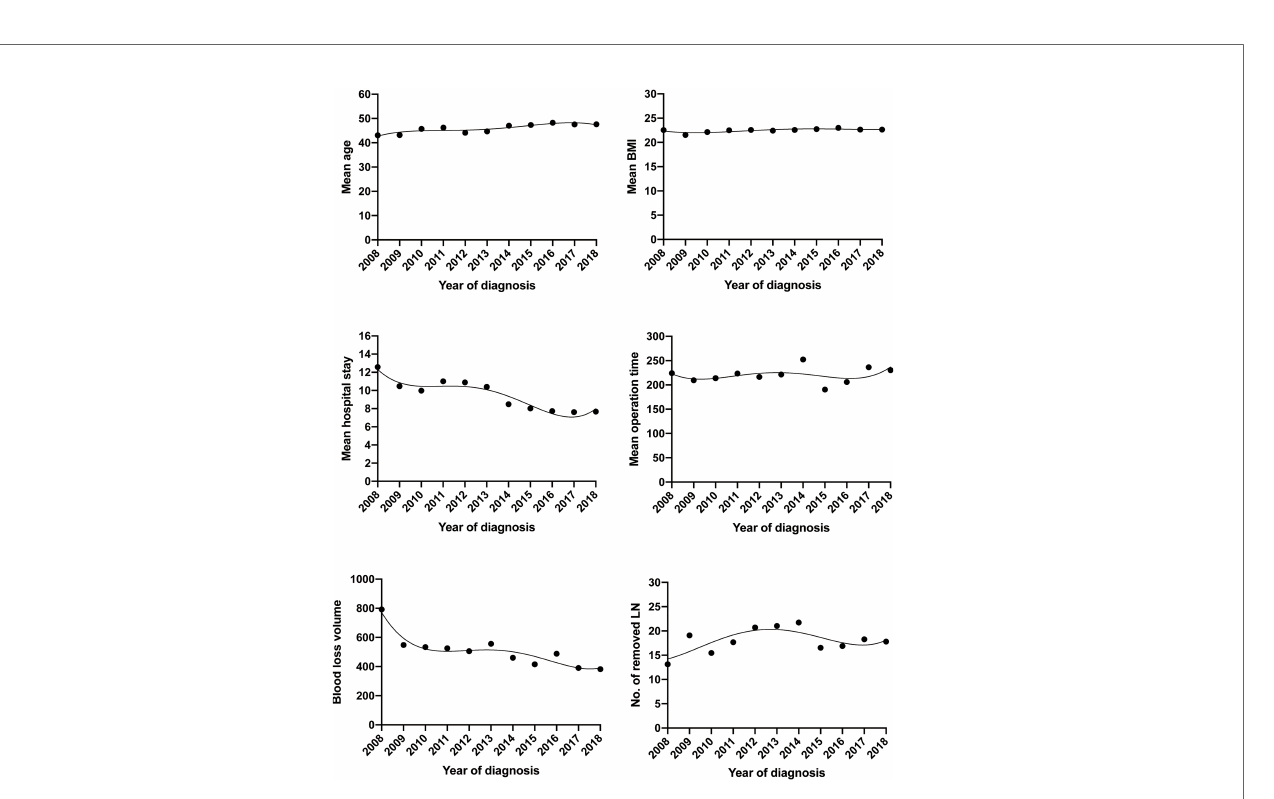
FIGURE 2 | Trends of demographics and surgical morbidities with open approach of early-stage cervical cancer over the past 11